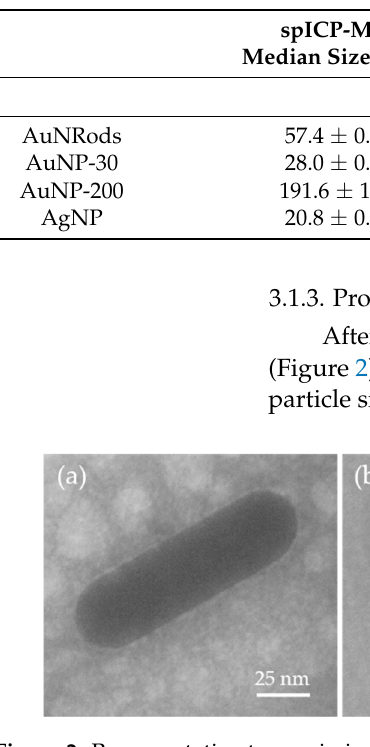
Table 1. Size distribution of metallic nanoparticles (mNP). The different nanoparticles (gold nanorods (AuNRods), gold nanoparticles (AuNP) and silver nanoparticles (AgNP)) were analyzed regarding their size distribution in the stock solution as well as in cell culture media. Two techniques, spICP-MS and TEM, were used. For AuNRods an equivalent spherical size was calculated from the particle mass obtained by spICP-MS.